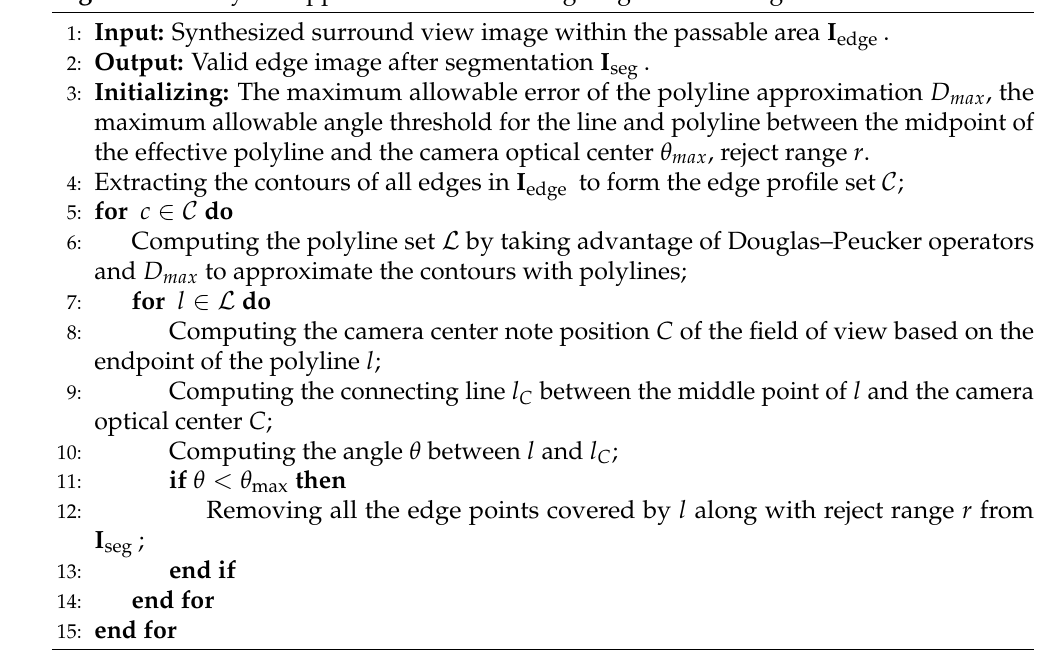
Algorithm 1 Polyline-approximation-based edge segmentation